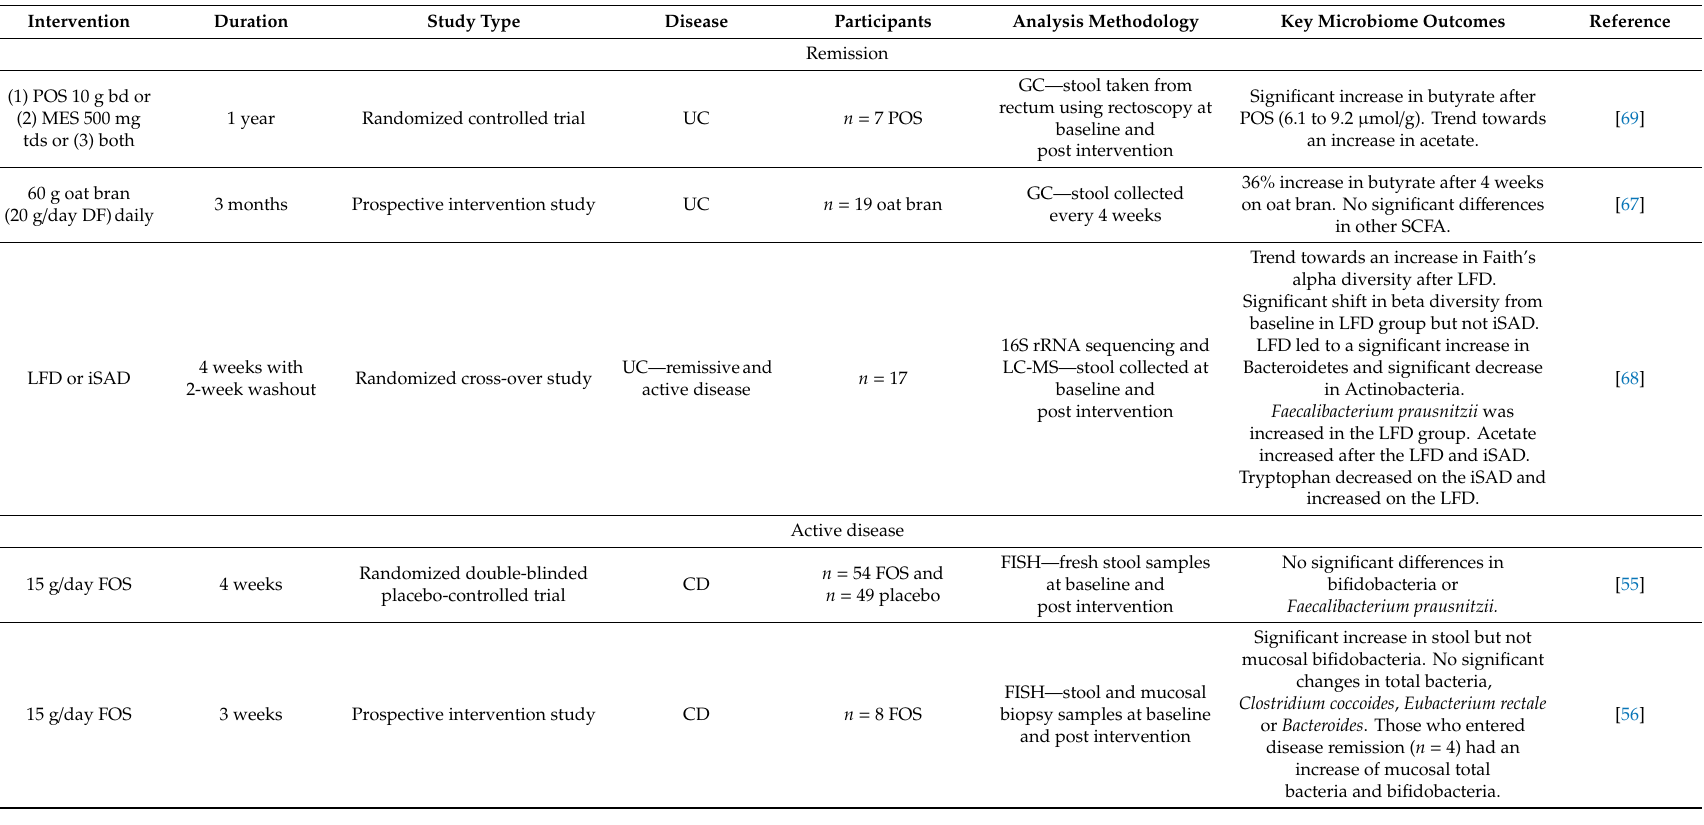
Table 2. Fiber and prebiotic intervention studies in adult IBD and their impact on the gut